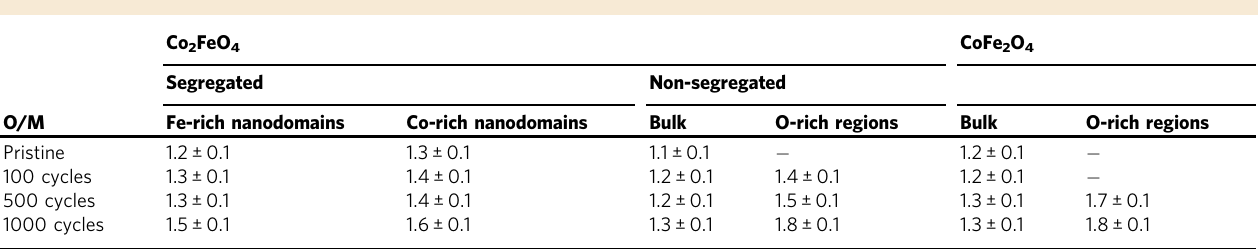
Table 2 Average O/M ratios in Co 2 FeO 4 and CoFe 2 O 4 nanoparticles during OER calculated by the total number of O and (Co + Fe) counts in all analysed datasets.